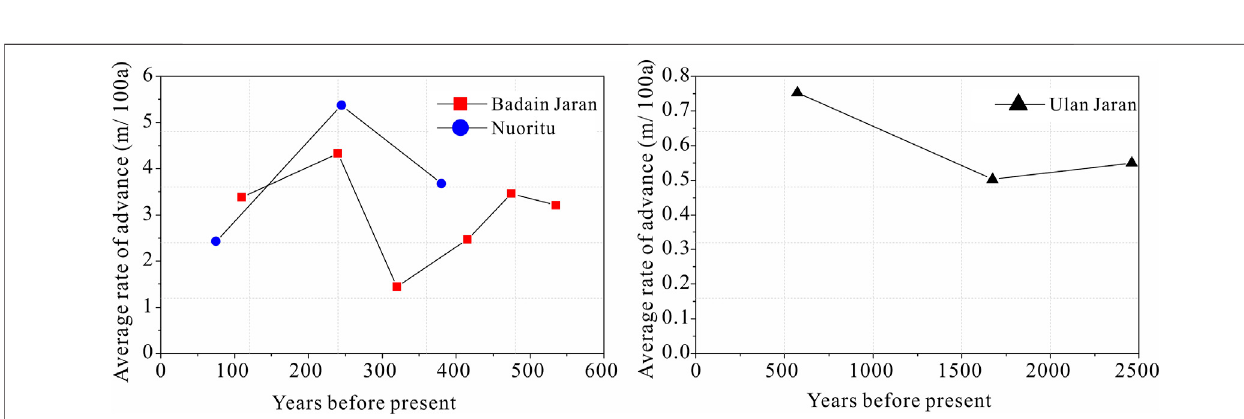
FIGURE 3 | Observed local air circulation that radiates from the interdune lakes (based on the unpublished data collected from wind towers).